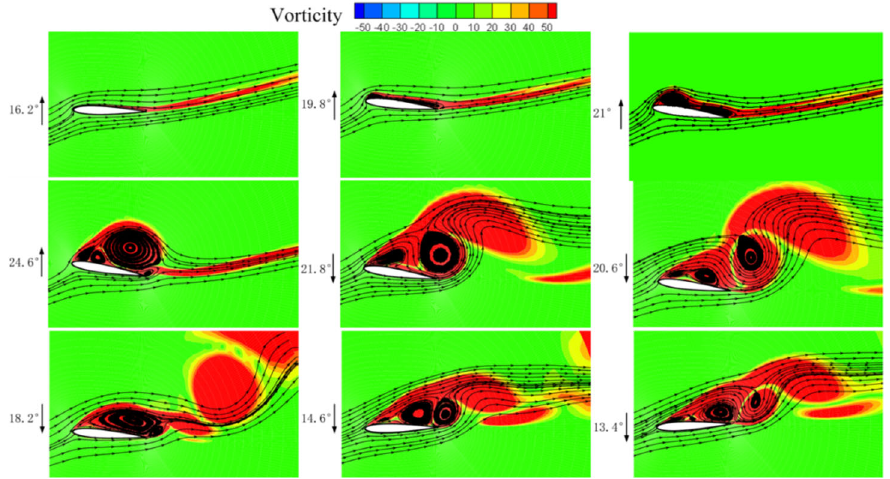
Figure 7. Vortex volume and streamlines corresponding to different angles of